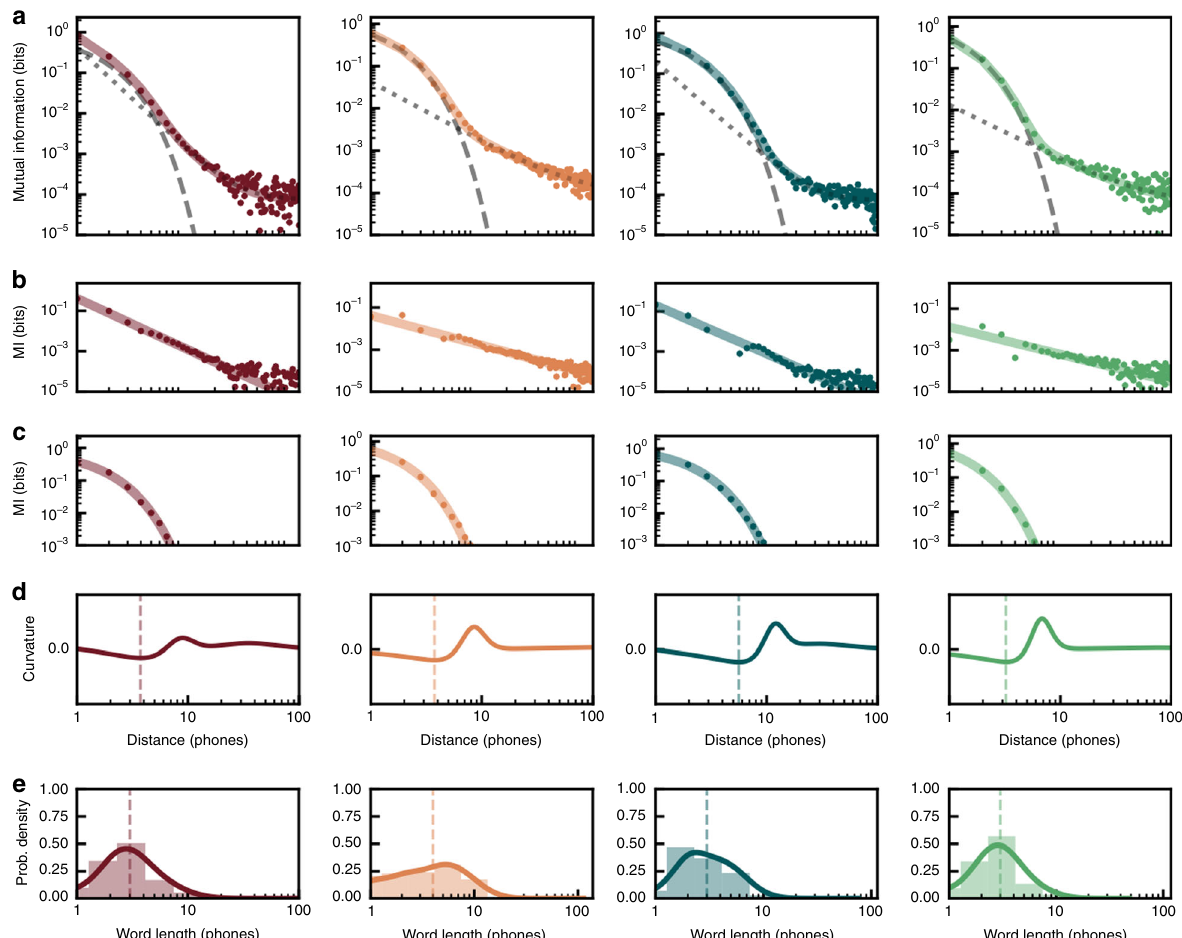
Fig. 3 Mutual information decay in human speech. a MI decay in human speech for four languages (maroon: German, orange: Italian, blue-green: Japanese, green: English) as a function of the sequential distance between phones. MI decay in each language is best fi t by a composite model (colored lines) with exponential and power-law decays, shown as a dashed and dotted gray lines, respectively. b The MI decay (as in a ) with the exponential component of the fi t model subtracted to show the power-law component of the decay. c The same as in b , but with the power-law component subtracted to show exponential component of the decay. d Curvature of the fi tted composite decay model showing the distance (in phones) at which the dominant portion of the decay transitions from exponential to power law. The dashed line is drawn at the minimum curvature for each language (English: 3.37, German: 3.57, Italian: 3.72, Japanese: 5.74) e Histograms showing the distribution of word lengths in phones, fi t with a smoothed Gaussian kernel (colored line). The dashed vertical line shows the median word length (German: 3, Italian: 4, Japanese: 3, English: